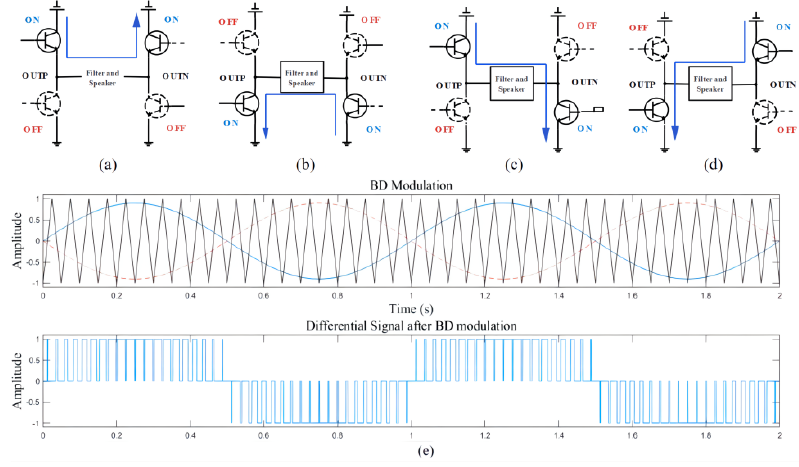
Figure 8. A BD/filterless modulation scheme ( a – d ) and BD/filterless waveforms ( e ) .